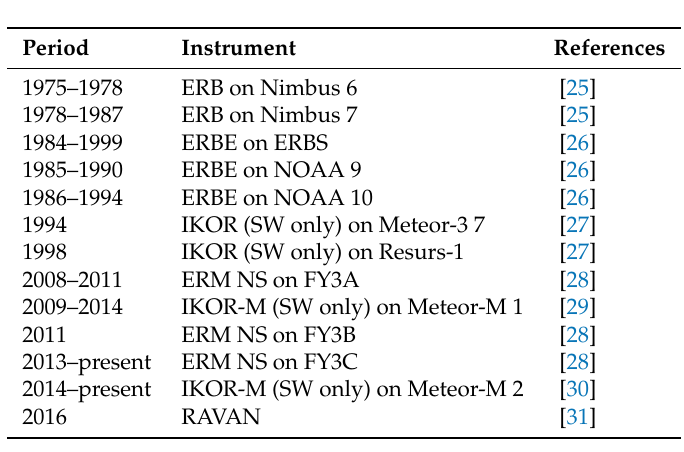
Table 3. Non-Scanning Broadband Earth Radiation Budget space instruments. IKOR: Short-wave outgoing radiation monitor; ERM: Earth Radiation Monitor; RAVAN: Radiometer Assessment using Vertically Aligned